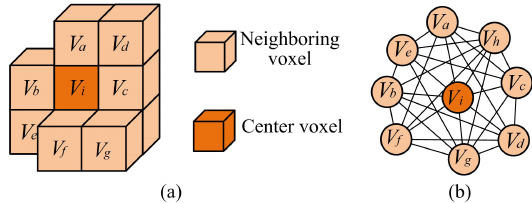
Figure 2. Connection types. (a) “ stair-like ” , (b) convex, and (c) concave connections.